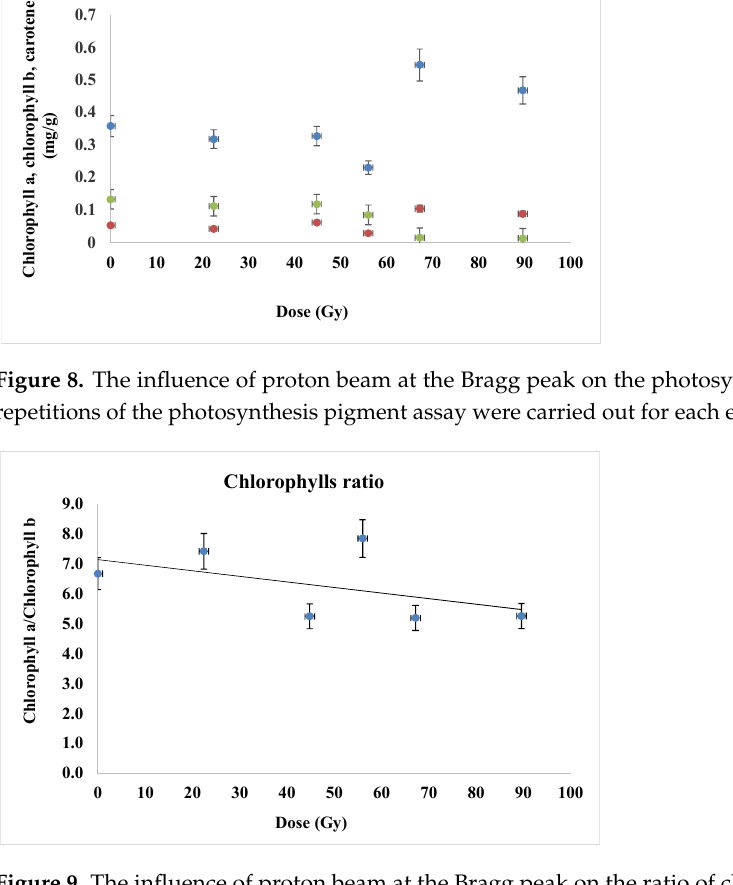
8 of 21 Figure 7. Normal and aberrant mitosis in Triticum aestivum L. root meristem cells after SOBP treatment. ( a – e ) normal inter-, pro-, meta-, ana- and telophase; ( f – h ) giant pro-, meta- and ana- phases; ( i ) comma shaped interphase; ( j ) torpedo shaped interphase; ( k , l ) micronuclei with differ- ent sizes (white arrows); ( m ) C-metaphase; ( n ) A-T with single bridge (black arrow); ( o ) A-T with two bridges (each black arrow); ( p ) disaster shaped anaphase and multiple bridges; ( q ) complex aberration (A-T with bridges and expelled chromosomes); ( r ) late anaphase with bridges (black arrow) and micronucleus (white arrow); ( s ) overlap chromatids (red arrow); ( t ) telophase with single bridge (black arrow). From each of the five microscope slides corresponding to each ex- perimental variant, between 2300 and 3100 cells were found and used for the cytogenetic analysis. 2.3. Photosynthesis Pigments